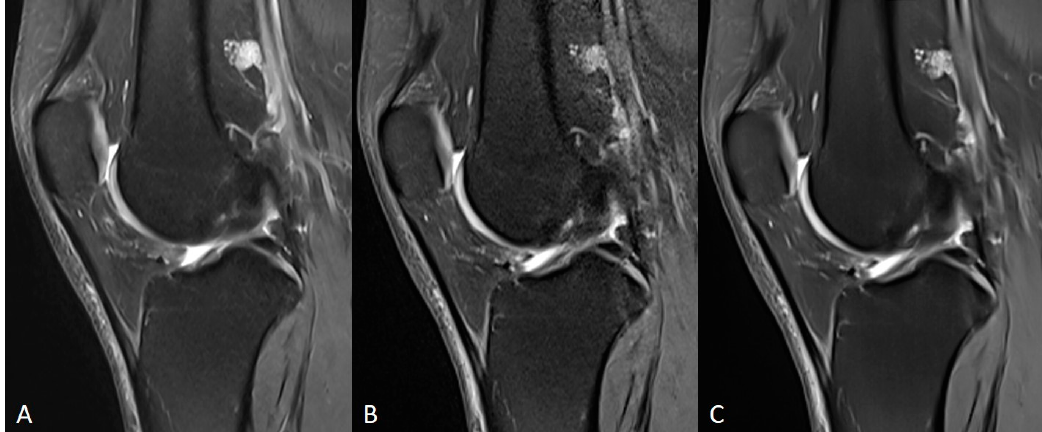
Figure 9. Comparison of TSE S ( A ), TSE DL raw data reconstructed with a standard (GRAPPA) method ( B ) and TSE DL ( C ) of a knee in sagittal orientation. Note that the extent of noise in TSE DL with standard reconstruction ( B ) is increased compared to TSE S ( A ) and TSE DL .